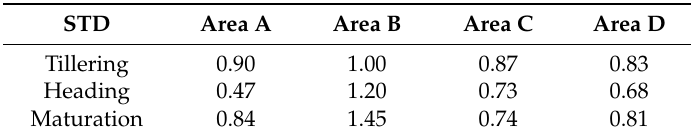
Figure 4. The averages of dates corresponding to the three phenological periods(the tillering period, the heading period, the maturation period) in the four experiment areas (Area A, Area B, Area C, and Area D), respectively. Table 3. The standard deviation of dates corresponding to the three phenological periods(the tillering period, the heading period, the maturation period) from the four experiment areas (Area A, Area B, Area C, and Area D) were counted, respectively.